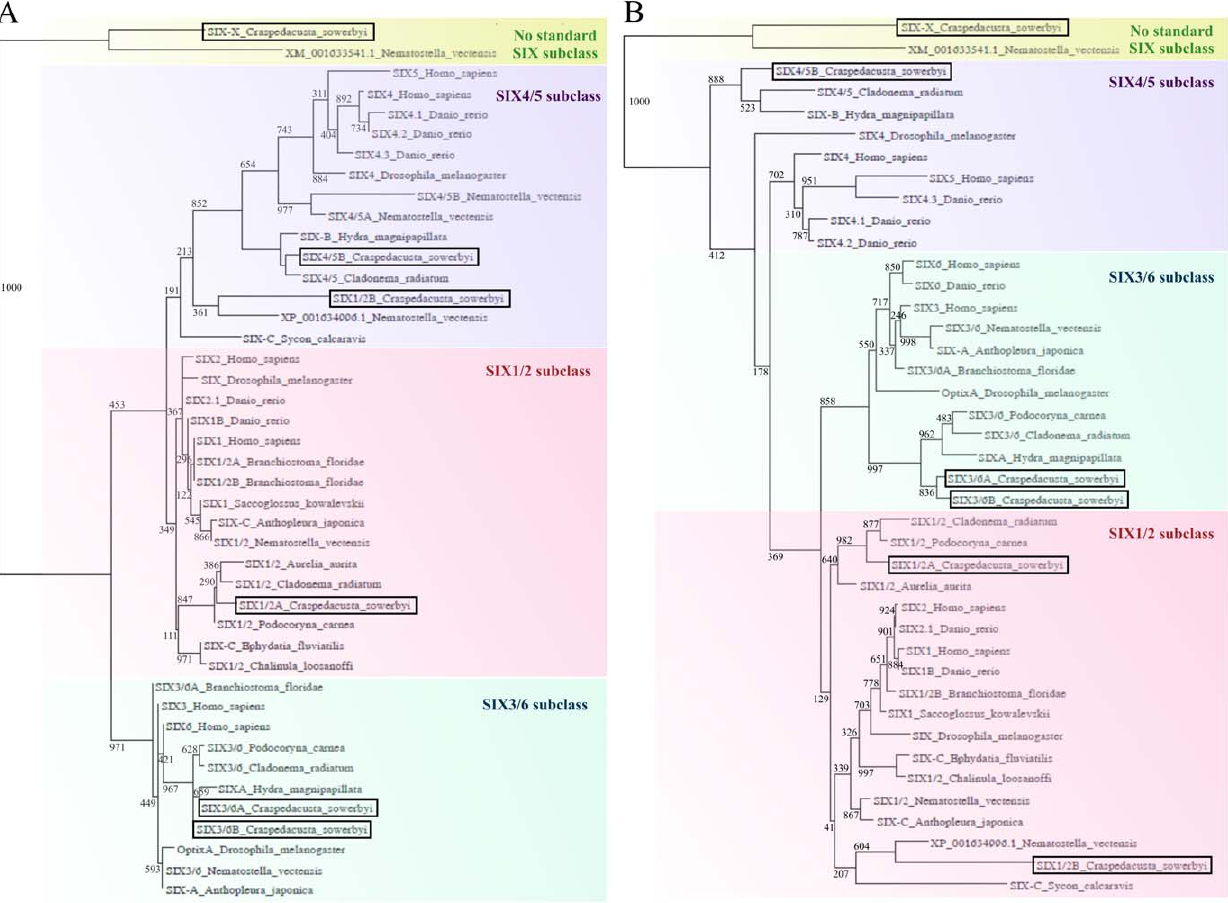
Figure 2. Comparison of phylogenetic trees of HD (A) and SD (B) regions of Six class transcription factors. The phylogenetic trees were calculated by the maximum likelihood method (WAG protein substitution model, bootstrap 1000) and processed by NJ Plot software. Phylogenetically representative sequences from the following metazoan animals were selected for comparison: sponges ( Chalinula loosanoffi, Ephydatia fluviatilis, Sycon calcaravis ), cnidarians ( Nematostella vectensis , Anthopleura japonica , Podocoryne carnea , Hydra magnipapillata , Cladonema radiatum , Aurelia aurita ), invertebrates ( Saccoglossus kowalevskii , Drosophila melanogaster , Branchistoma floridae ) and vertebrates ( Danio rerio and Homo sapiens ). For the list of ID numbers of reference sequences see Text S1.